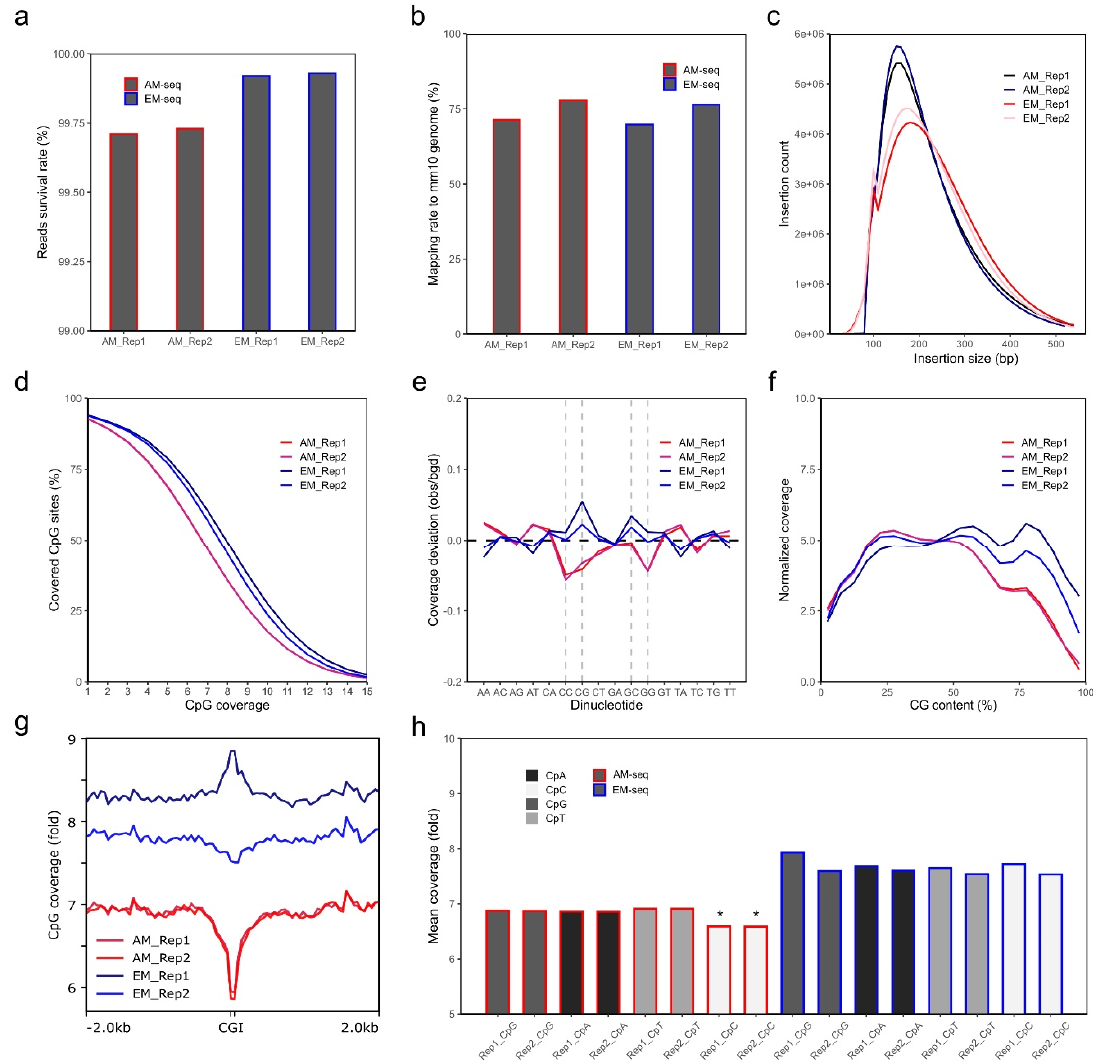
Figure 1. Quality analysis of NAc D2-MSN methylome libraries. ( a ) Survival rate of sequencing reads for each library. The calculation was performed after adaptor trimming, quality trimming, and short reads removal. Y-axis starts from 99%. ( b ) Unique alignment rate of each library. ( c ) Library insertion size distribution and count numbers. Data were extracted only from aligned fragments. ( d ) Cumulative coverage plot shows percentages of CG sites (out of all CG sites in the mm10 genome) reaching a certain amount of CpG coverage. Data of CpG coverage from 1- to 15-fold are shown. ( e ) Coverage deviation between AM-seq and EM-seq at each dinucleotide context. CC, CG, GC, and GG are dash-lined to highlight the divergent biases between AM-seq and EM-seq. ( f ) The normalized coverage according to CpG content percentage. ( g ) CpG coverage at around CpG islands (CGIs). Coverage data of CGI with extended 2 kb up- and down-stream regions are plotted with a 50 bp bin size. ( h ) The mean coverage at each CpN context (CpA, CpC, CpG, CpT). Note the relative lower coverage of CpC in AM-seq samples (*).